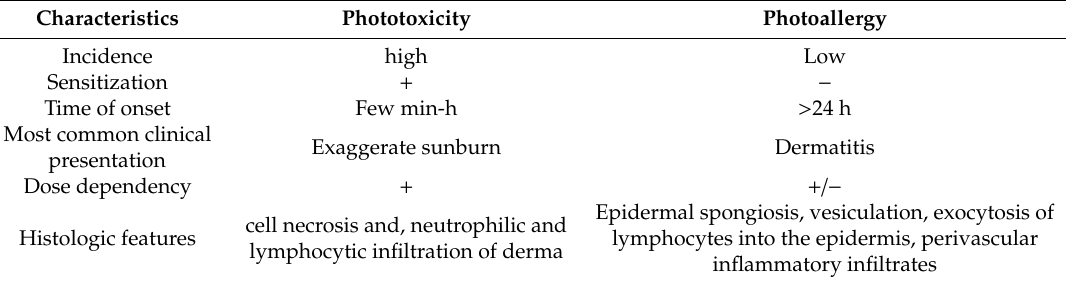
Table 1. Main features of phototoxicity and